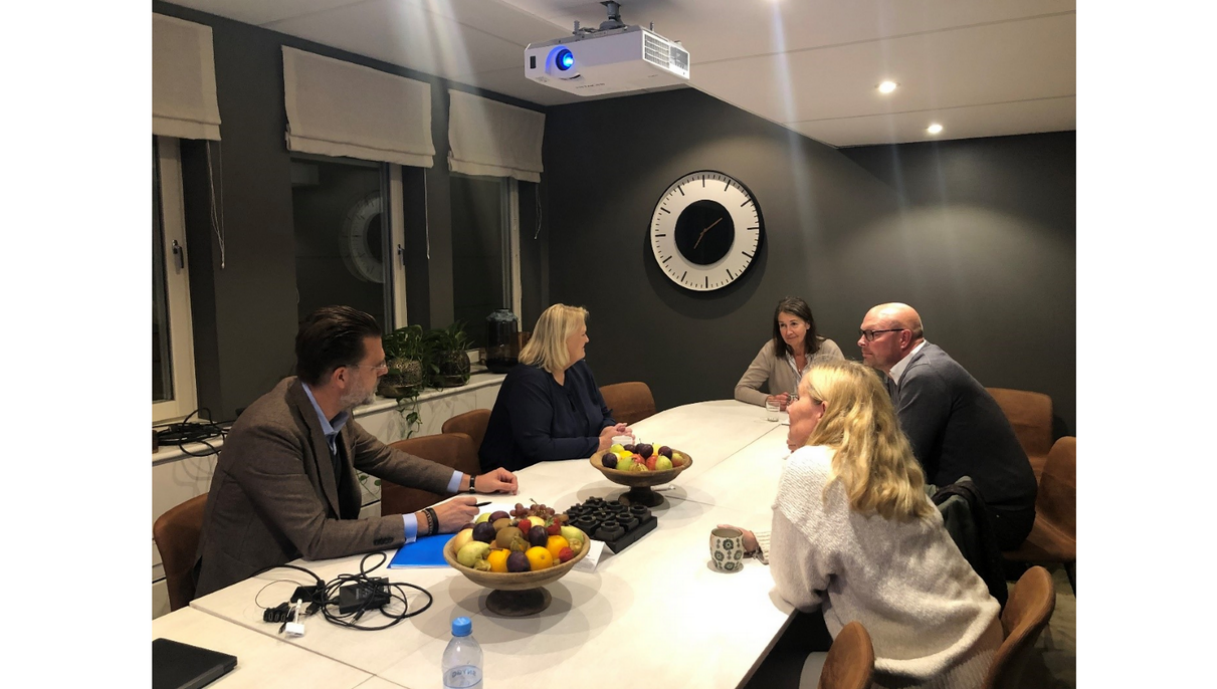
Figure 2. The patient research partners meeting during the final feedback concerning the internet-based cognitive behavioral therapy